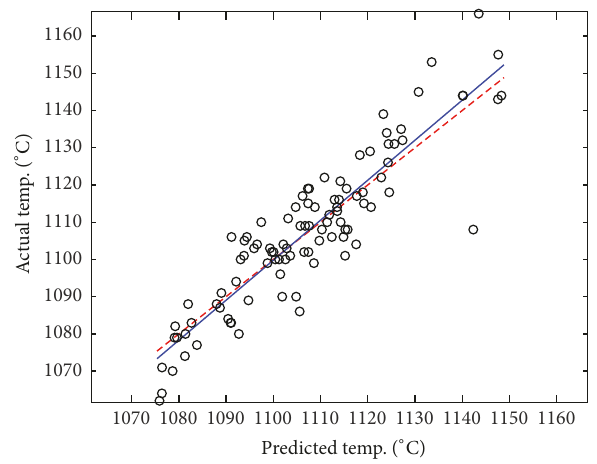
Figure 5: Dispersion graph between actual recharge temperature and those predicted by the